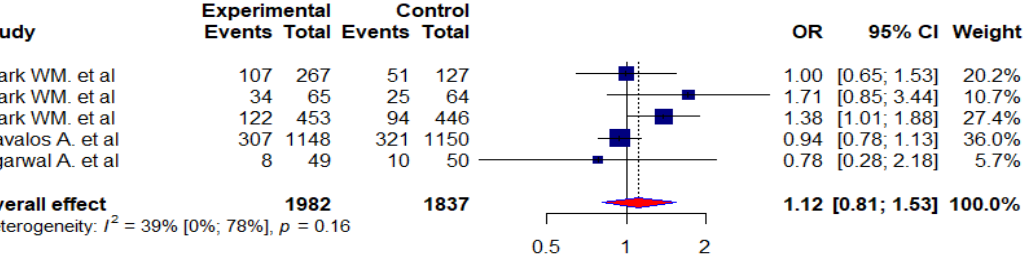
Figure 4. The forest plot of treatment effect of citicoline on outcomes of activities of daily living for patients with acute stroke (using BI > 95).